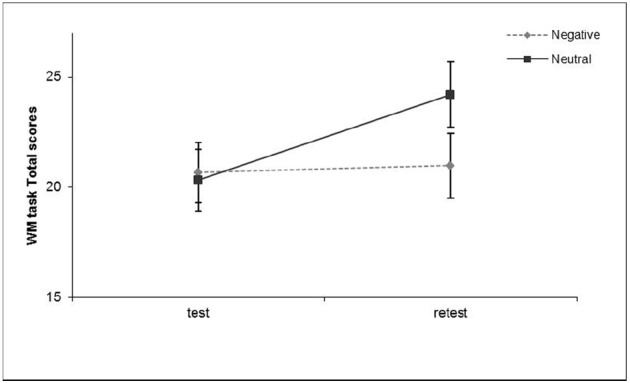
Two-way interaction effects of Emotional valence by Test–retest on the WM performance scores, Experiment 2. The two-way interaction of Emotional valence by Test–retest on the executive performance scores was significant, in that practice improved participants’ performance after the exposure to the neutral film, but was ineffective in the negative emotional condition. These findings demonstrates that the exposure to an emotional film hinders the practice effects upon the WM performance, independent on the sensory modality of the task. Error bars represent ± 1 SE.